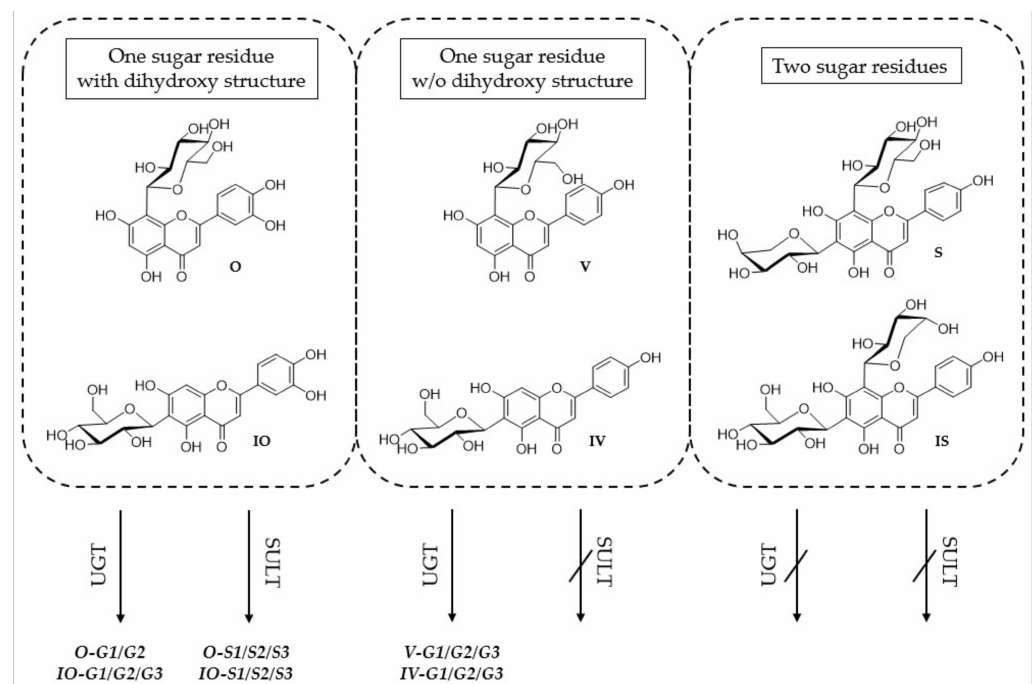
Figure 5. Relation between the structures of the six flavone C-glycosides, orientin (O), isoorientin (IO), vitexin (V), isovitexin (IV), schaftoside (S), and isoschaftoside (IS), and their metabolism through phase II enzymes in the